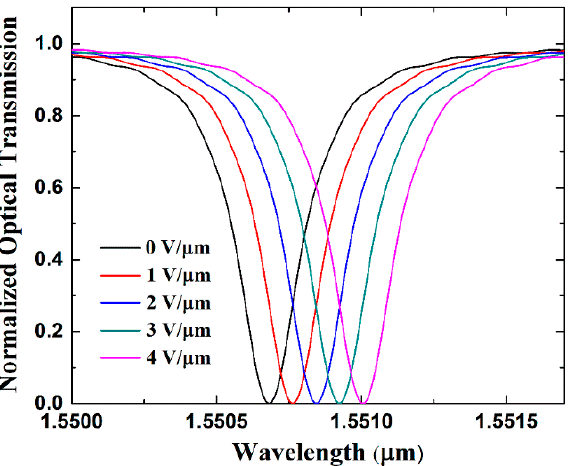
Figure 7. Graph showing the wavelength shift of the transmission spectrum at different electric field intensities. In this case, a TM mode and a microring with a 20 μ m radius are used.